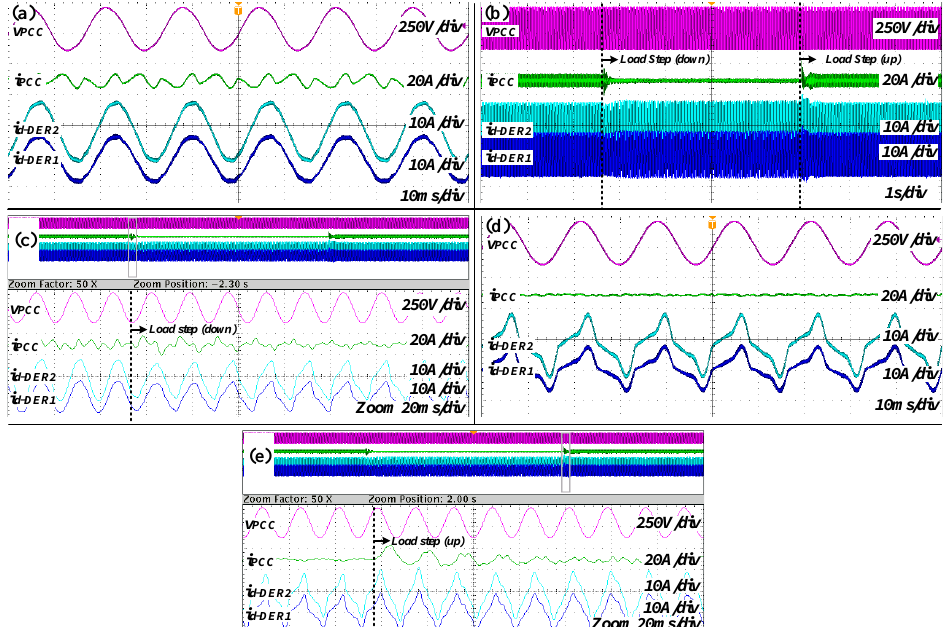
Figure 11. Experimental results: full current control under limited power capability. ( a ) d-DER 1 and d-DER 2 with 50% smaller ratings than nominal values in Table 2; ( b ) load steps applied disconnecting and connecting load L 2 ; ( c ) zoom-in view of stage one in ( b ); ( d ) steady-state condition of ( c ); ( e ) zoom-in view of stage two in ( b ). From top to bottom: PCC voltage and current, d-DER 2 and d-DER 1